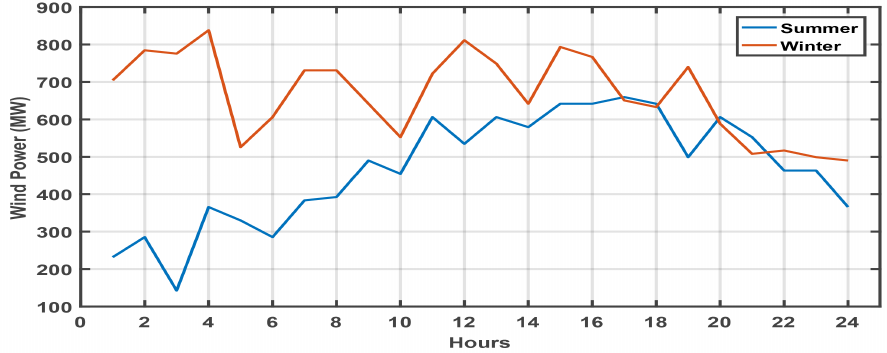
Figure 3. Hourly wind power generation on Jeju